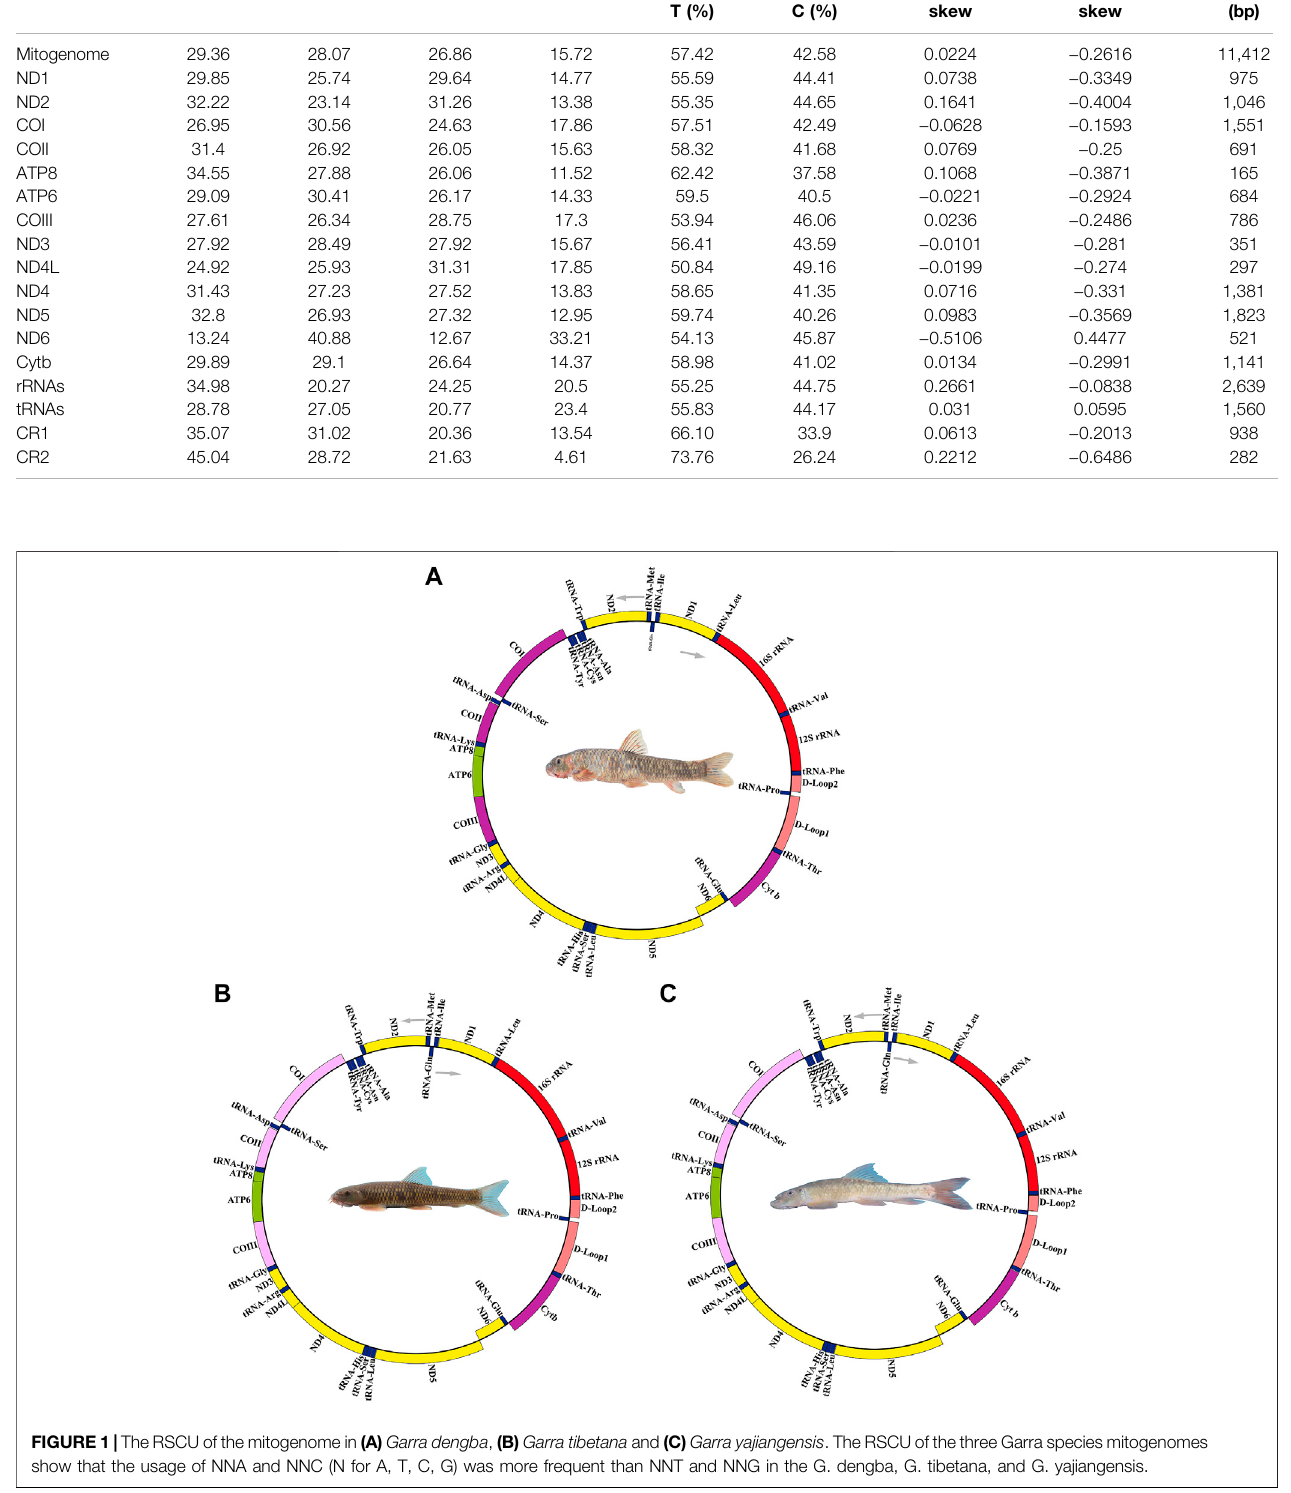
Frontiers in Genetics |